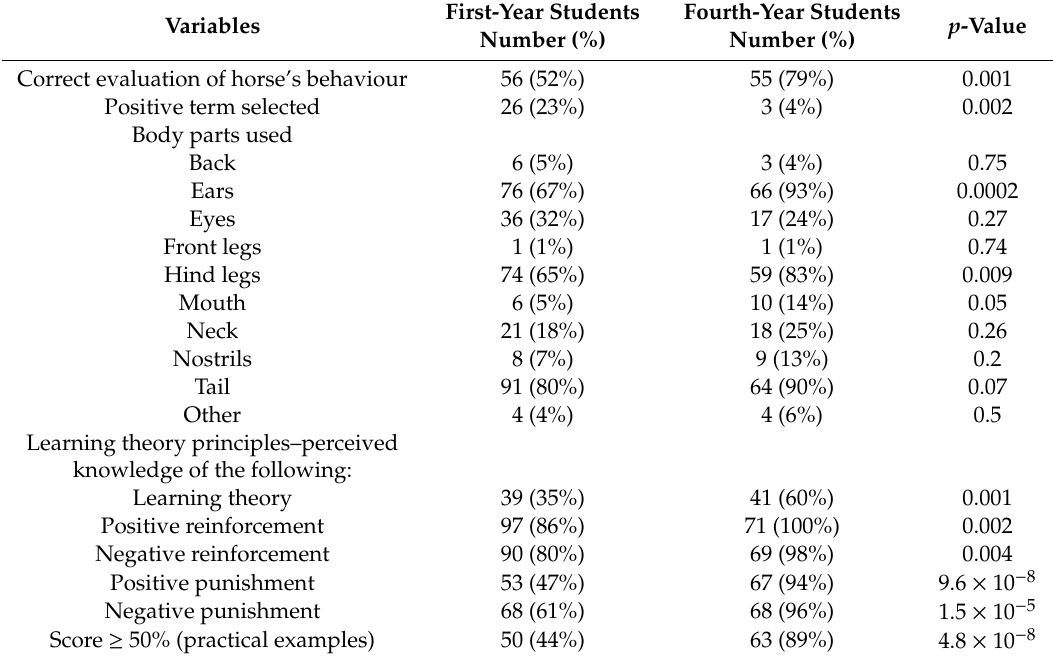
Table 4. Distribution of first-(n = 115 / 186) and fourth-year (n = 71 / 186) veterinary students’ responses to the evaluation of the horse’s behaviour in picture and knowledge of general equine behaviour principles. p -values were obtained from binary logistic regressions when comparing the distribution of variables between first- and fourth-year students.